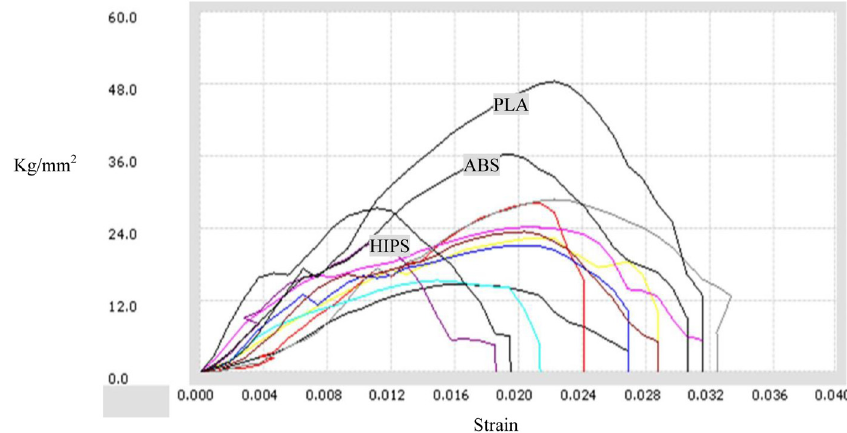
Figure 15. Stress vs. strain curves for 3D printed multi-material component in pull out